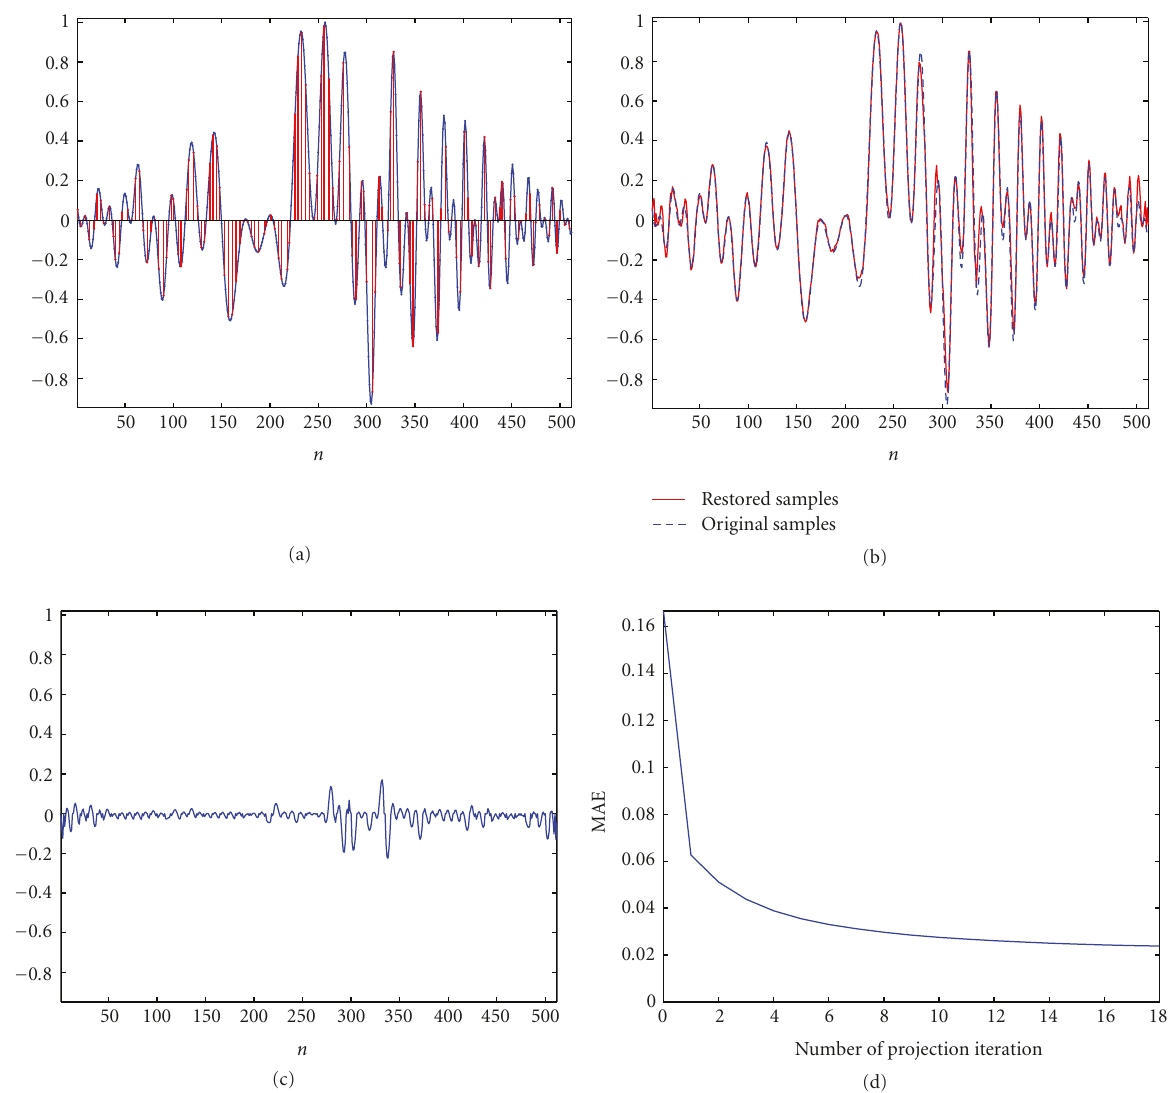
Figure 6: Restored results for the chirp signal ( N = 512). (a) Irregularly-spaced subsamples ( L = 4, τ ∼ N (0,1 / 2)), (b) restored signal by bandpass DPSS ( K = 64, W c = 1 / 16) based DET, (c) error, (d) convergence